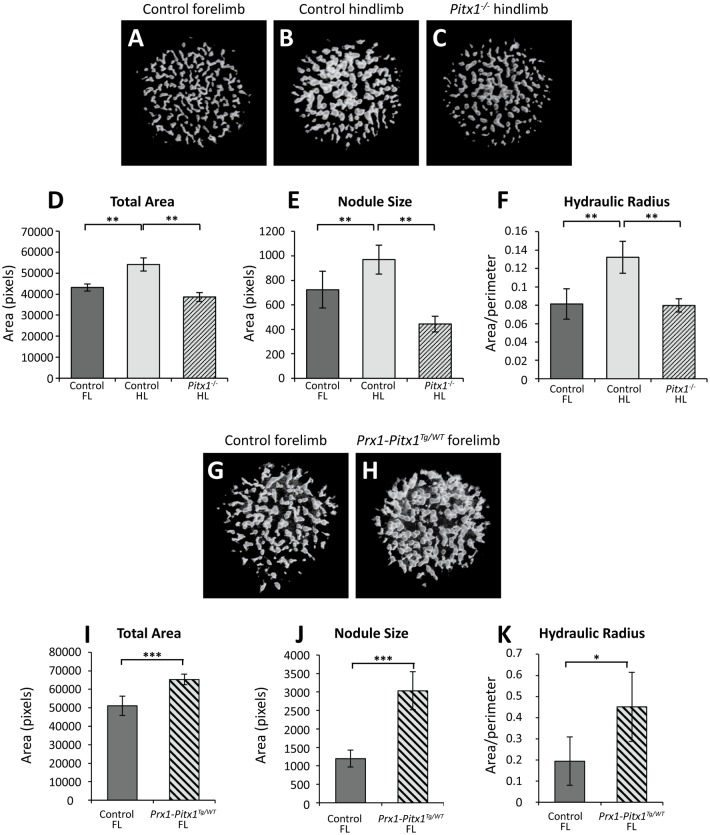
Pitx1 determines nodule morphology in vitro.A–C; Representative black and white images of 11.5dpc control forelimb (A) and hindlimb (B) and Pitx1-/- hindlimb (C) micromasses stained for Alcian blue. D–F; Quantification of samples represented by A–C. Chondrogenic nodules in micromasses established from control hindlimbs (B) have larger total area, are larger in size (both measured by number of pixels) and have a larger hydraulic radius (D–F) than control forelimbs (A). In contrast, nodules in micromasses established from Pitx1-/- hindlimbs (C) are significantly smaller, cover less total area, and have a smaller hydraulic radius than control hindlimb cultures (B, D–F) Control FL and HL; n = 6, Pitx1-/- HL; n = 4. G–H; Micromasses generated from Prx1-Pitx1Tg/WT forelimbs (H) which ectopically express Pitx1 contain nodules which are larger and have a higher hydraulic radius, and cover a larger total area than control forelimb cultures (G, I–K). *p<0.05, **p<0.01, ***p<0.001, Student’s t-test.